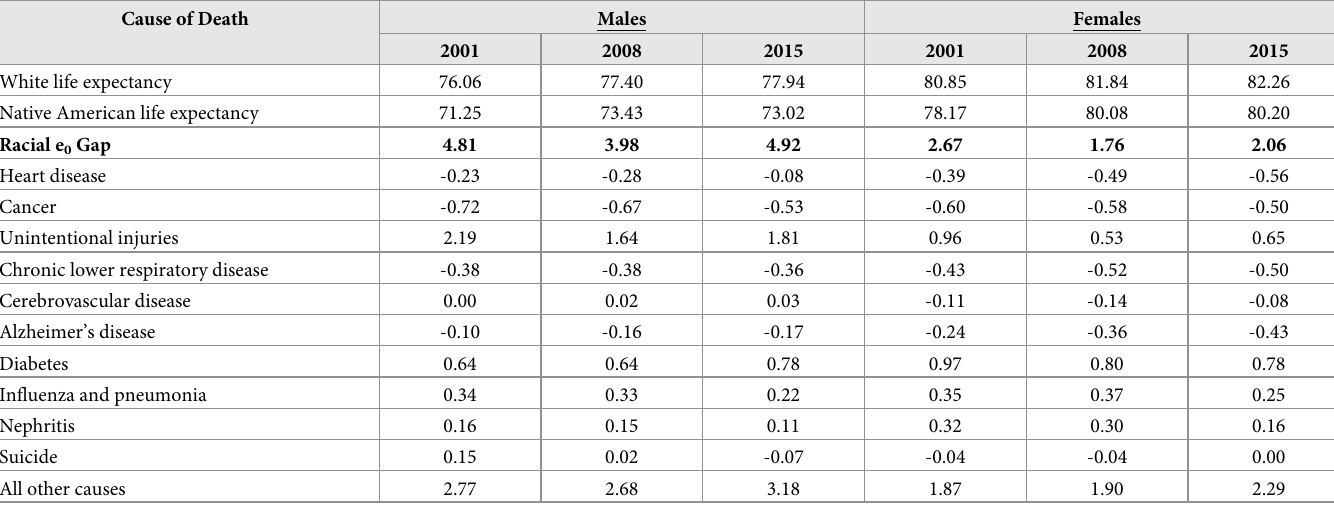
Table 1. Contribution of ten leading U.S. causes of death to Native American-White life expectancy gaps in the Four Corners States. Cause of Death